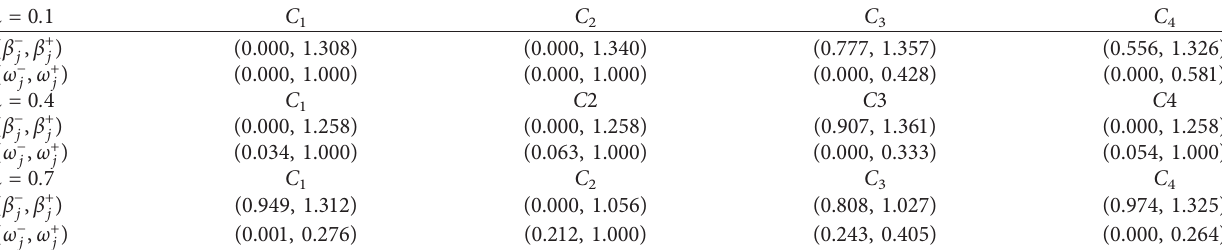
Table 13: Results of stable weight intervals using the WSI method. λ � 0 .